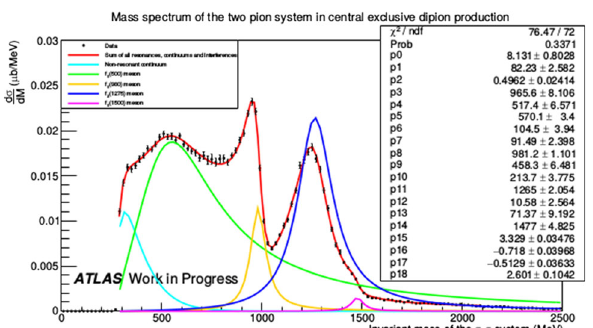
Fig. 6 Invariant mass distribution of pion pairs measured by the LHCb Collaboration (Figure taken from Ref.